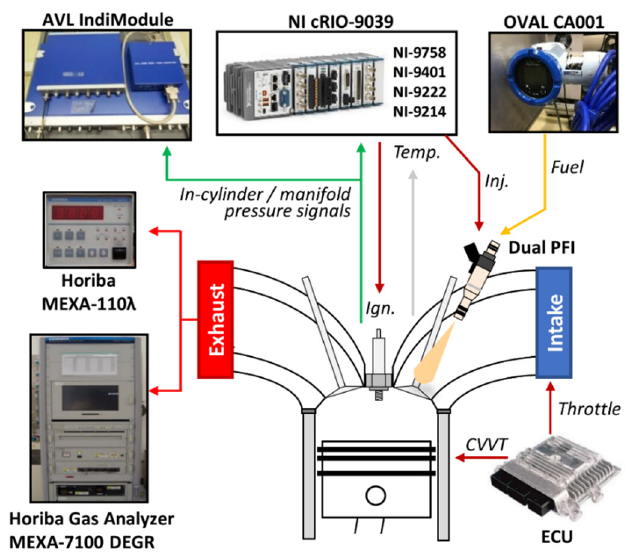
Figure 1. Engine test configuration